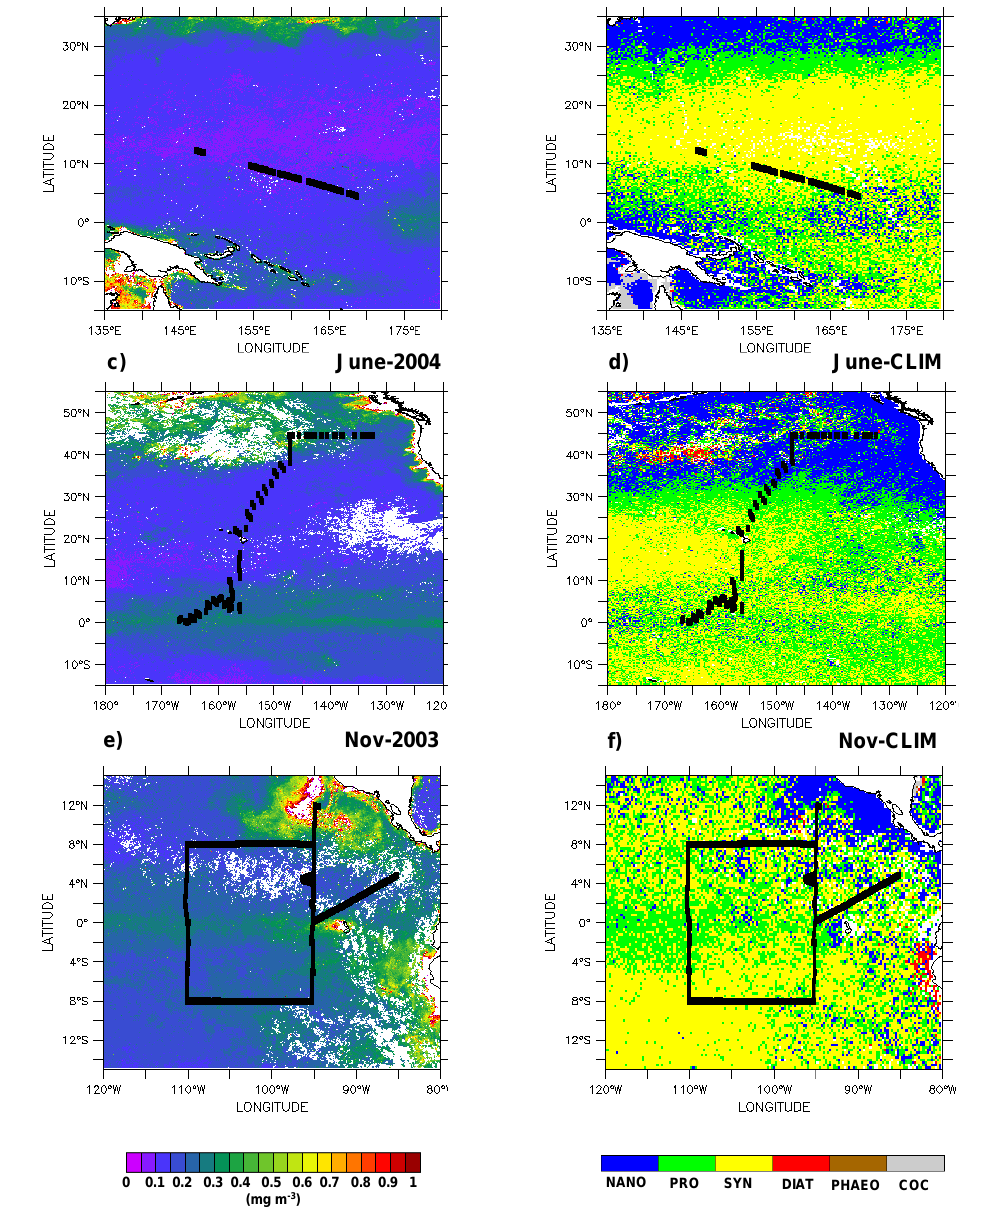
Fig. 2. Regional monthly composites of Chl concentration (left panels, units mgm − 3 ) and monthly climatological composites (1998–2006) of the dominant phytoplankton groups detected by PHYSAT (right panels). (a, b) western Equatorial Pacific, (c, d) central Equatorial Pacific and eastern North Pacific, (e, f) eastern Equatorial Pacific. Dominant phytoplankton groups are: nanoeucaryotes (NANO), Prochloroccocus (PRO), Synechococcus (SYN), diatoms (DIAT), Phaeocystis-like (PHAEO) and coccolithophores